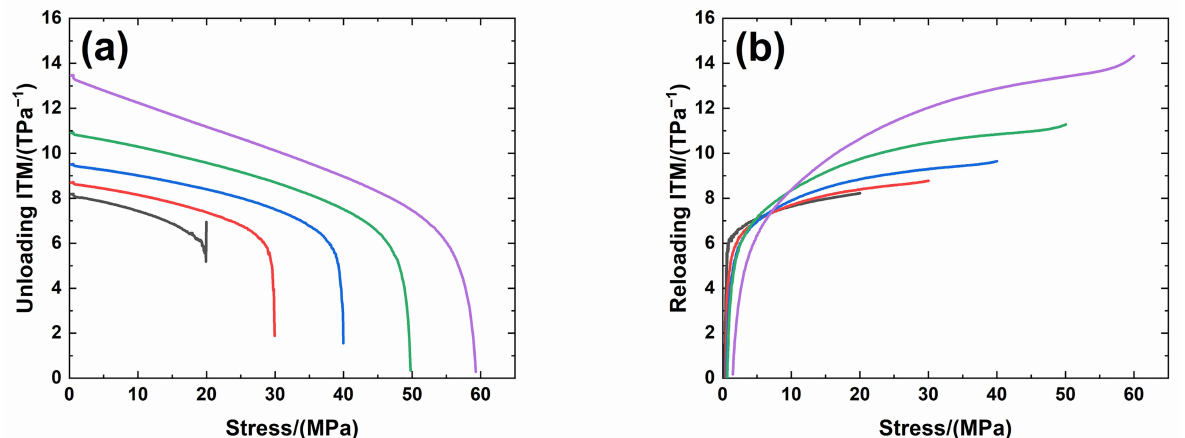
Figure 10. ( a ) Unloading ITM; and ( b ) reloading ITM of Type 3 3D needle-punched C/SiC composite.